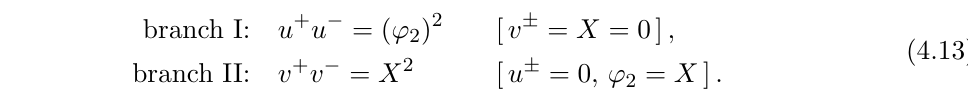
and NS5 (with Hanany-Witten D3 creation (1 ; 1)